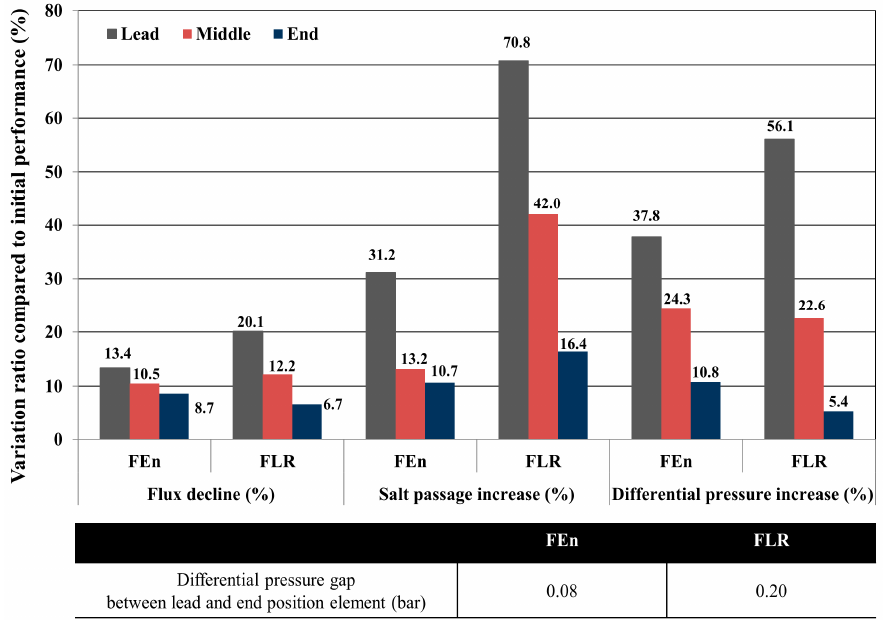
Figure 10. Comparison of the individual element flux decline, salt passage increase, and differential pressure variation according to the installed position in a vessel. pressure variation according to the installed position in a